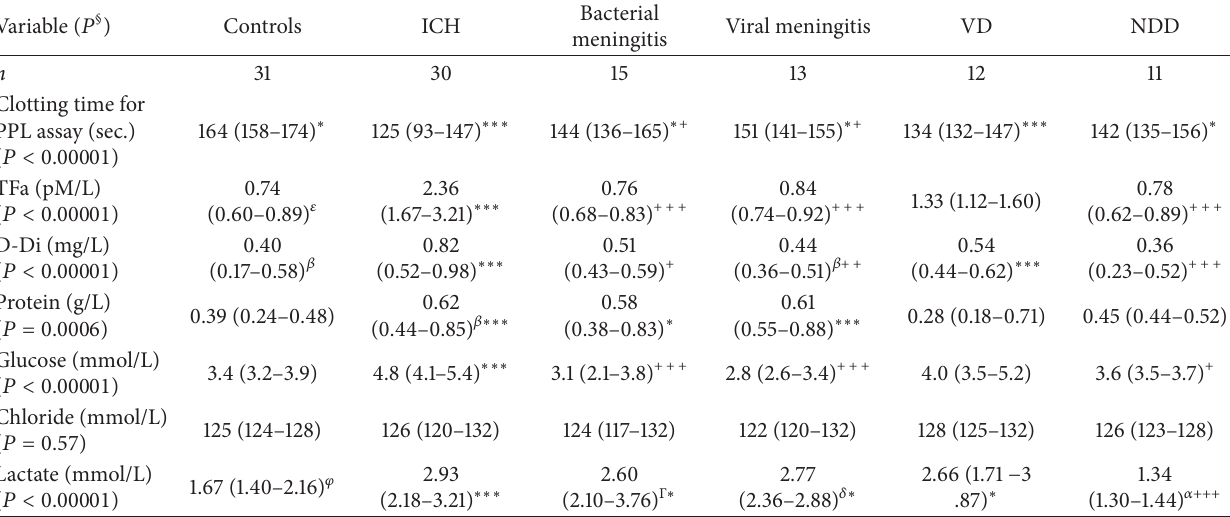
Table 1: Levels of procoagulant phospholipids (PPLs), tissue factor activity (TFa), D-Dimer (D-Di), and classical biochemical parameters in the cerebrospinal fluid of different groups of patients with central nervous system